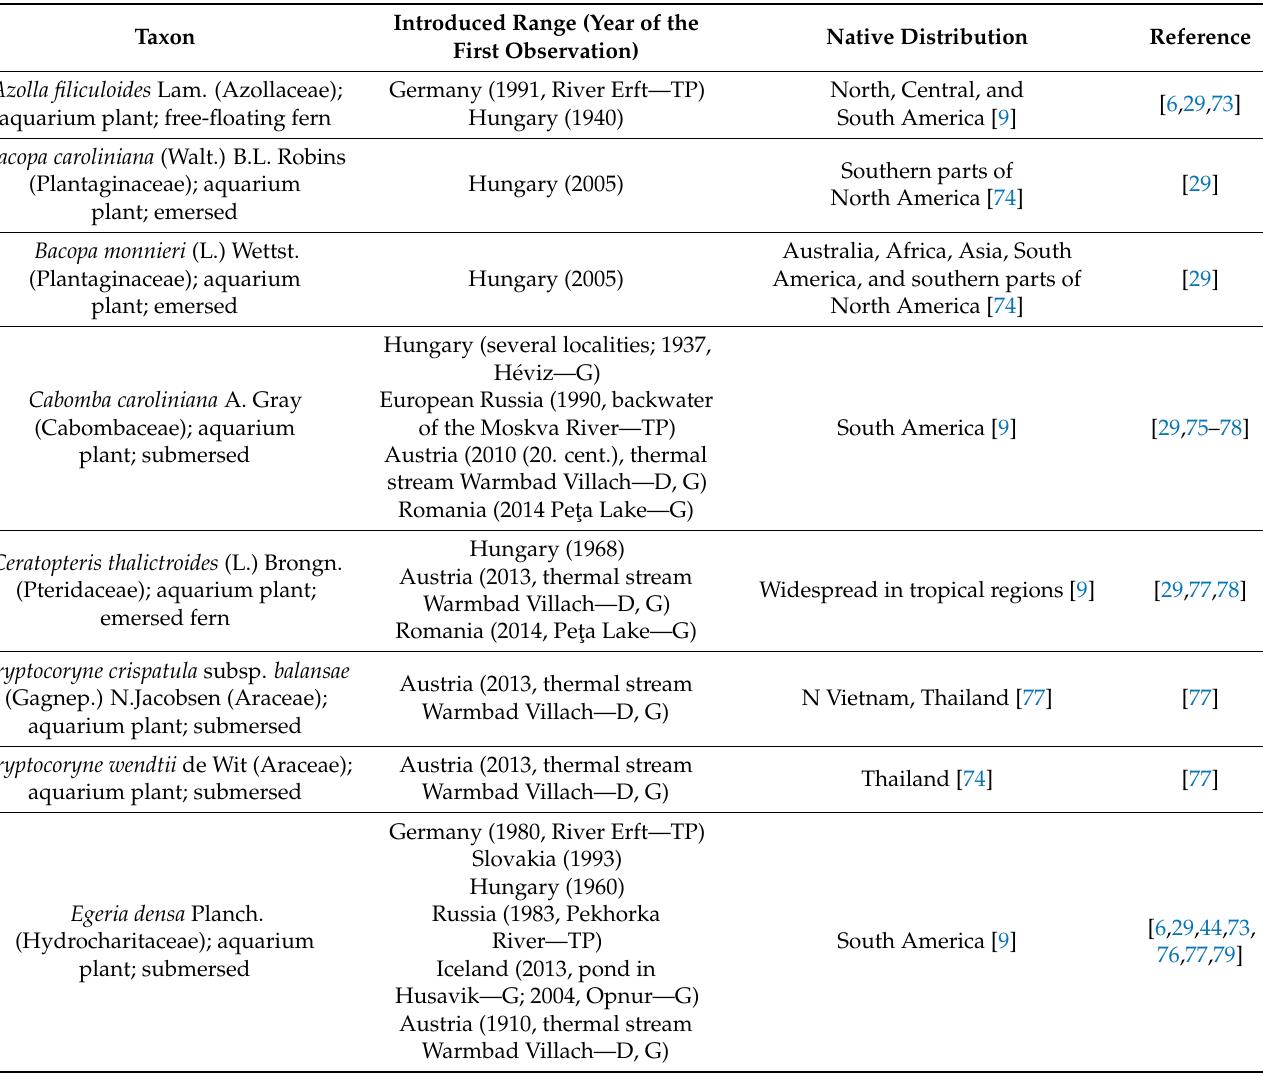
Table A1. List of alien aquatic plant taxa associated with thermally abnormal waters in Europe, including family, pathway, growth form, and EPPO A2 categorization. For each taxon, the year of the first record in a particular country and the native distribution are provided. Source of thermal abnormality (if the information was provided in the reference): G = natural geothermal spring, TP = thermal pollution, D = discharge of a thermal